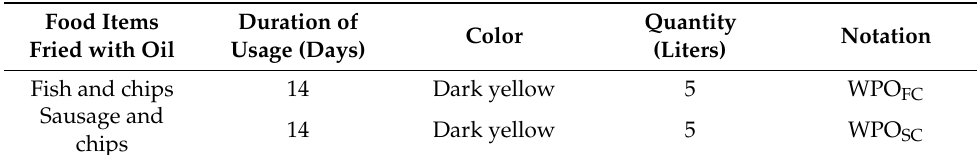
Table 1. Information on the collected WPO samples.